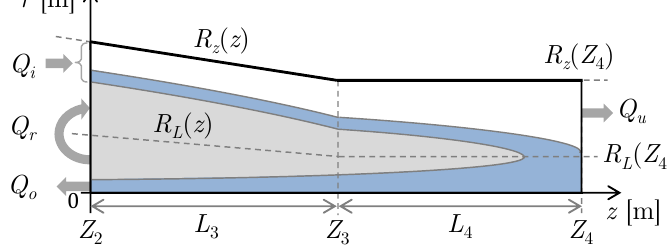
Figure 9. Symmetric illustration of the flow inside S 3 − 4 . Q i eventually leaves the hydrocyclone through the white region to the underflow or blue region to the overflow [56]. The grey region illustrates the volume occupied by Q r .